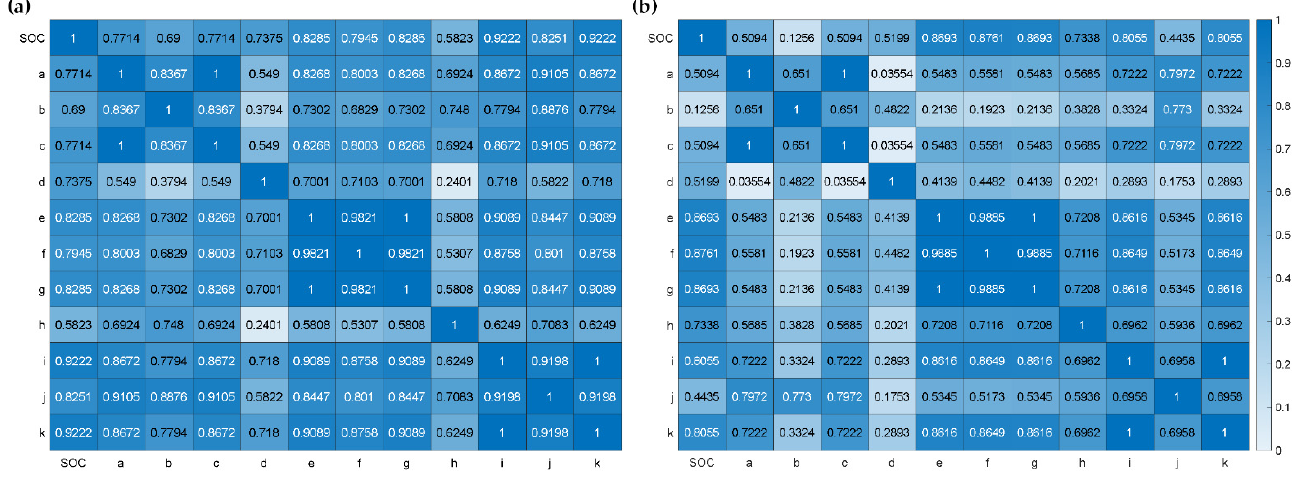
Figure 8. Correlation coefficient between UGW characteristic parameters and battery SOC. ( a ) Charge data; ( b ) discharge data. Table 6. Comparison of dispersion analysis of “point” parameters and “line” parameters.